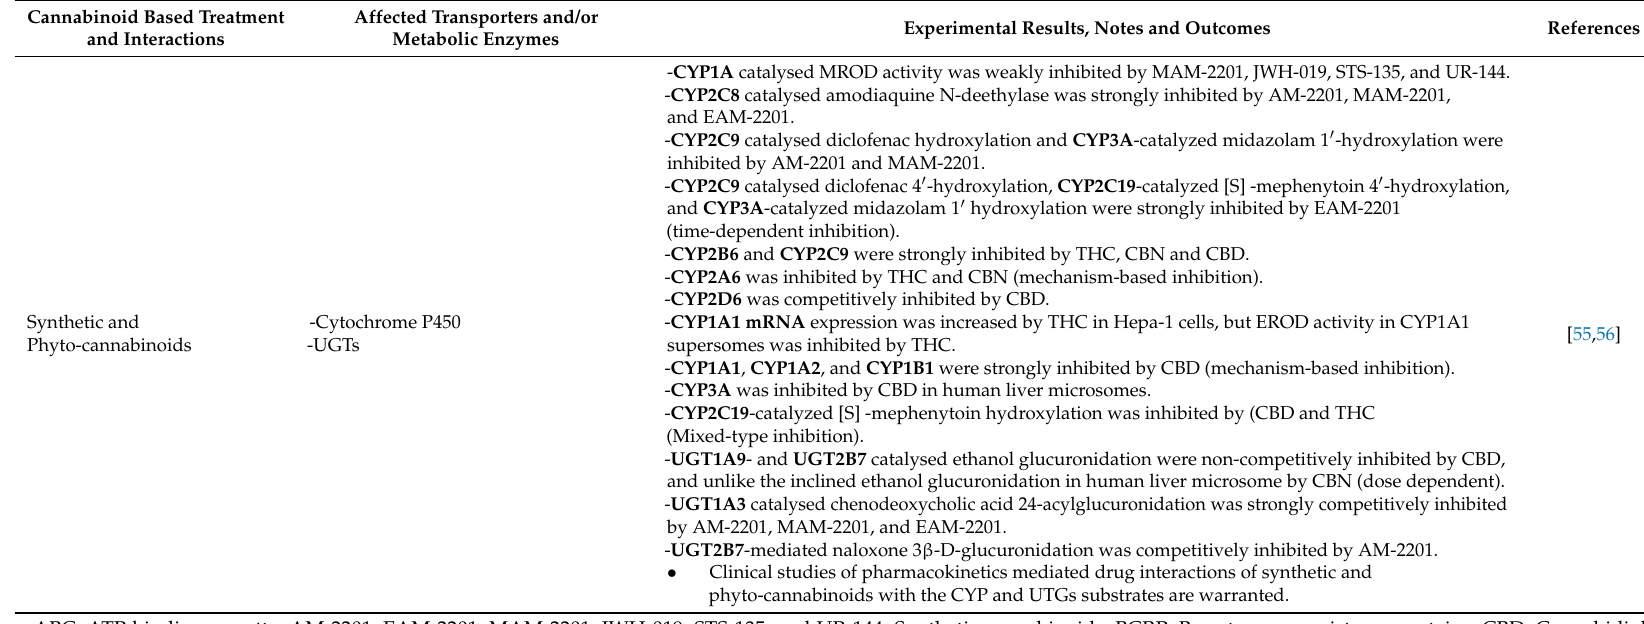
Affected Transporters and/or Metabolic Enzymes